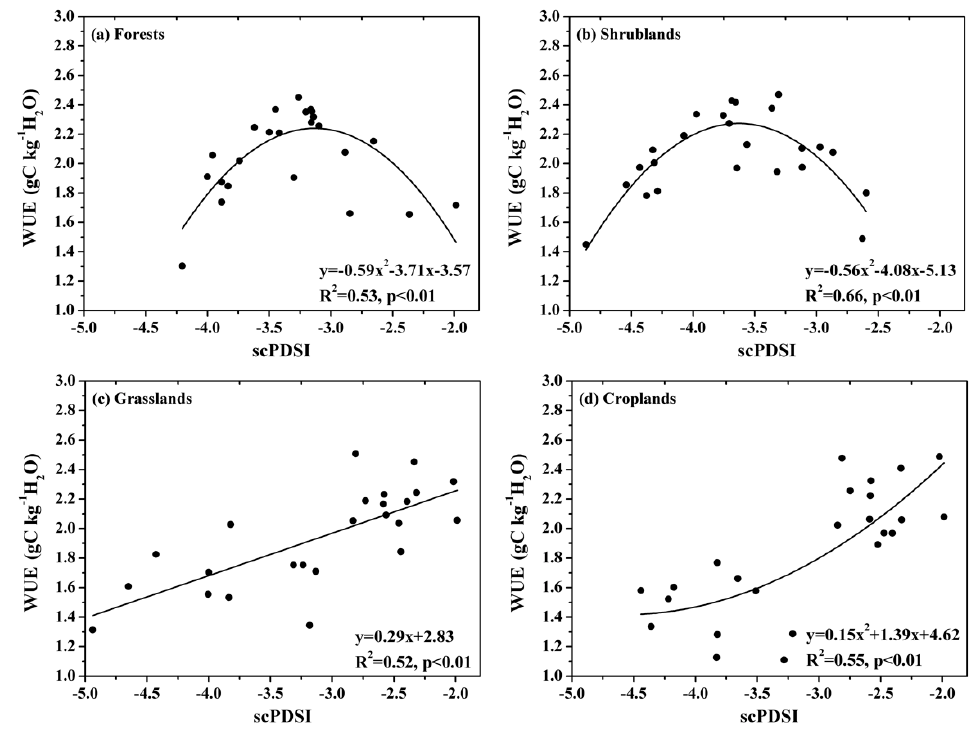
Figure 10. Responses of WUE to drought at the monthly timescale in areas affected by severe drought for different vegetation types: ( a ) forests; ( b ) shrublands; ( c ) grasslands; ( d ) croplands.